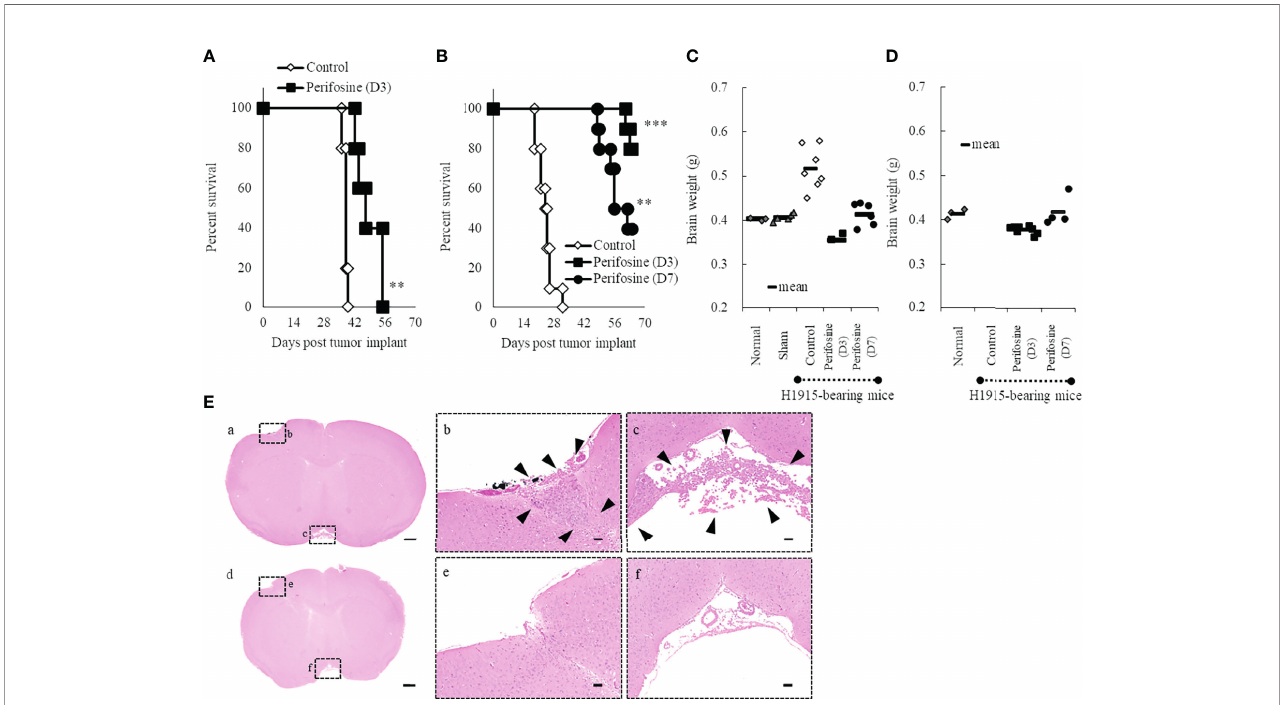
FIGURE 3 | Prolongation of life-span of orthotopic brain metastasis mice with perifosine. Mice were injected intracerebrally with DU 145 (A) or H1915 (B – E) cells on day 0, and the tumor was allowed to establish until day 3 (perifosine [D3]) or day 7 (perifosine [D7]). Mice were treated with either vehicle or perifosine under the conditions indicated in Tables 1 , 2 . (A, B) Survival curve analysis was performed for 64 days, and the death time point was de fi ned when the animals appeared moribund. ** p < 0.01; *** p < 0.001 versus the control group. (C, D) The H1915 orthotopic tumor mice were euthanized in a moribund state ( C ; up to day 63) or at the termination of the experiment ( D ; on day 64), and each brain was weighed. Although all 10 mice in the control group were euthanized in a moribund state until day 32, the brains were weighed only for seven mice (C) . Age-matched normal (n = 3) and sham-operated (n = 5) mice were included for comparison and euthanized on day 21 (C) . (E) Representative H&E-stained images of lesions in the H1915 model are shown; scale bar = 500 m m (a, d) or 50 m m (b , c , e , f) . Low (a) and high (b, c) power views in the vehicle-treated mouse on day 14 and low (d) and high (e, f) power views in the perifosine (D3)-treated mouse on day 41. Boxed areas in panels (a) and (d) show regions depicted in panels (b, c, e, f) , respectively. Arrowheads indicate tumor